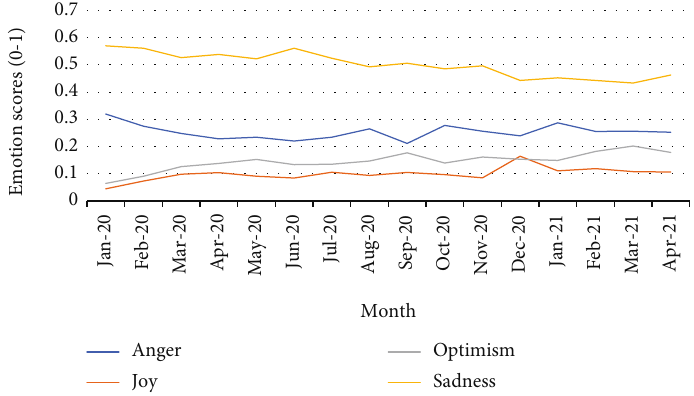
Figure 7: Chart showing monthly average emotion scores across the Daily Mail Online news tweets over time.